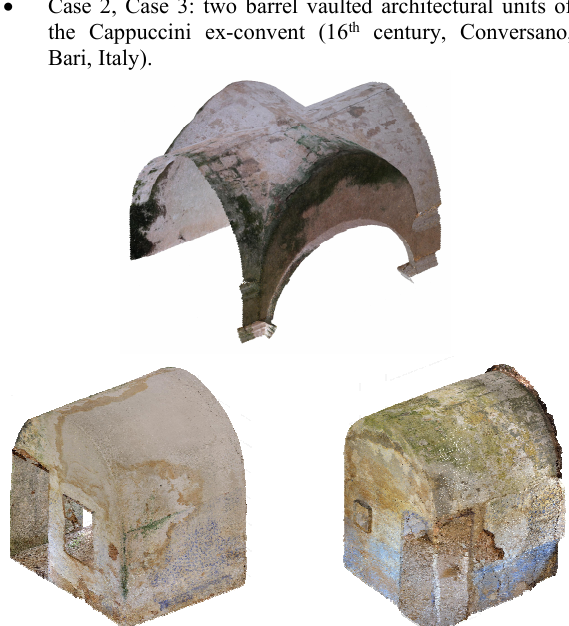
Figure 2 . Top: Case 1; Bottom: Case 2 (left), Case 3 (right)